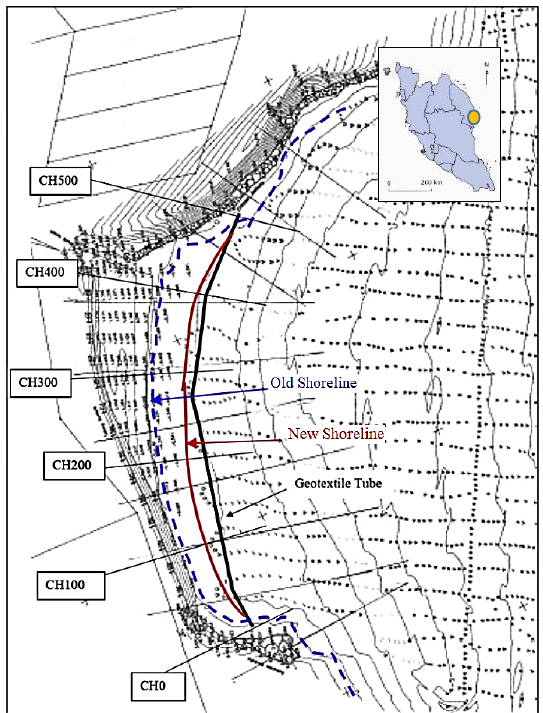
Figure 14. Geotube as submerged dykes in Teluk Kalong, Terangganu [99]. ‘Reproduced with permission from [99], 2012; Elsevier.' Johor is a state in the southern region of Peninsular Malaysia that has an effect of hydrodynamics forces, sediment supply, geomorphology, and antecedent topography with close relations with current and wave from Malacca and Singapore Straits. Tanjung Piai beach, Johor is located at the most southern tip of Asia is classified under Category 1 coastal erosion, where mangrove forest is critically eroded. The muddy coast is also facing oil spill incidents, which caused degradation of mangrove and eventually increased the erosion process. Protection structures, such as geotextile tubes, sea wall, revetment, and offshore breakwater, are implemented in phases [100]. Geotubes of over 1.5 km long with the cost of USD 0.7 million were built between 2003 and 2006 along the Tanjung Piai beach. However, due to the soft soil at the seafloor, the structure sank into the mudflat and lost its capability to protect the coast. It was also observed that offshore breakwaters have successfully safeguarded the mangrove forest from further deterioration. The structures led to sediment accumulation at the up-drift side and corresponding minor erosion on the downdrift side. The reduction of current speed and wave height behind the structures allowed calmer conditions for mangrove growth. Besides, the function of the geotextile tube as a breakwater to minimize the scouring effect at the toe and mud floor is forecasted to occur due to turbulence generated by wave energy reflection at Tanjung Piai, Johor. Tan et al. [101] also observed that the breakwaters created a calmer water surface at the shoreward side. Figure 15 shows the schematic diagram and photo of the geotubes at Tanjung Piai Johor. It has obtained substrate build-up significantly close to the shoreline.